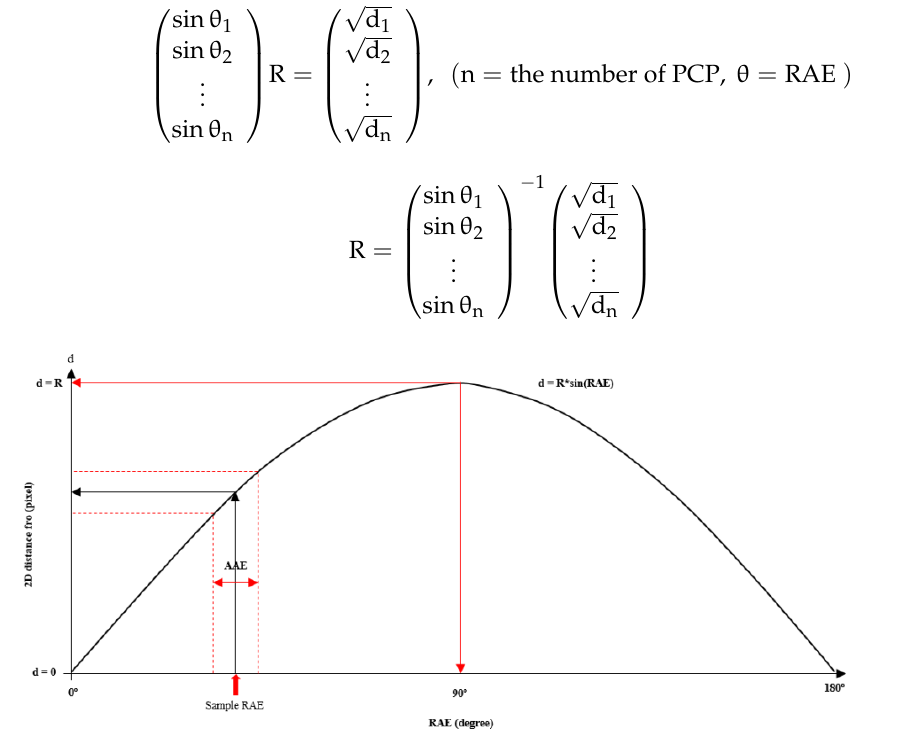
Figure 8. Distance in xy-plane of ORCP and PCP according to